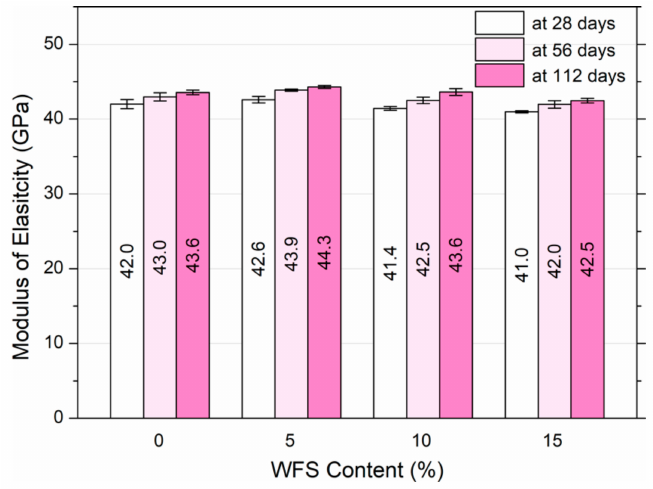
Figure 5. Modulus of elasticity